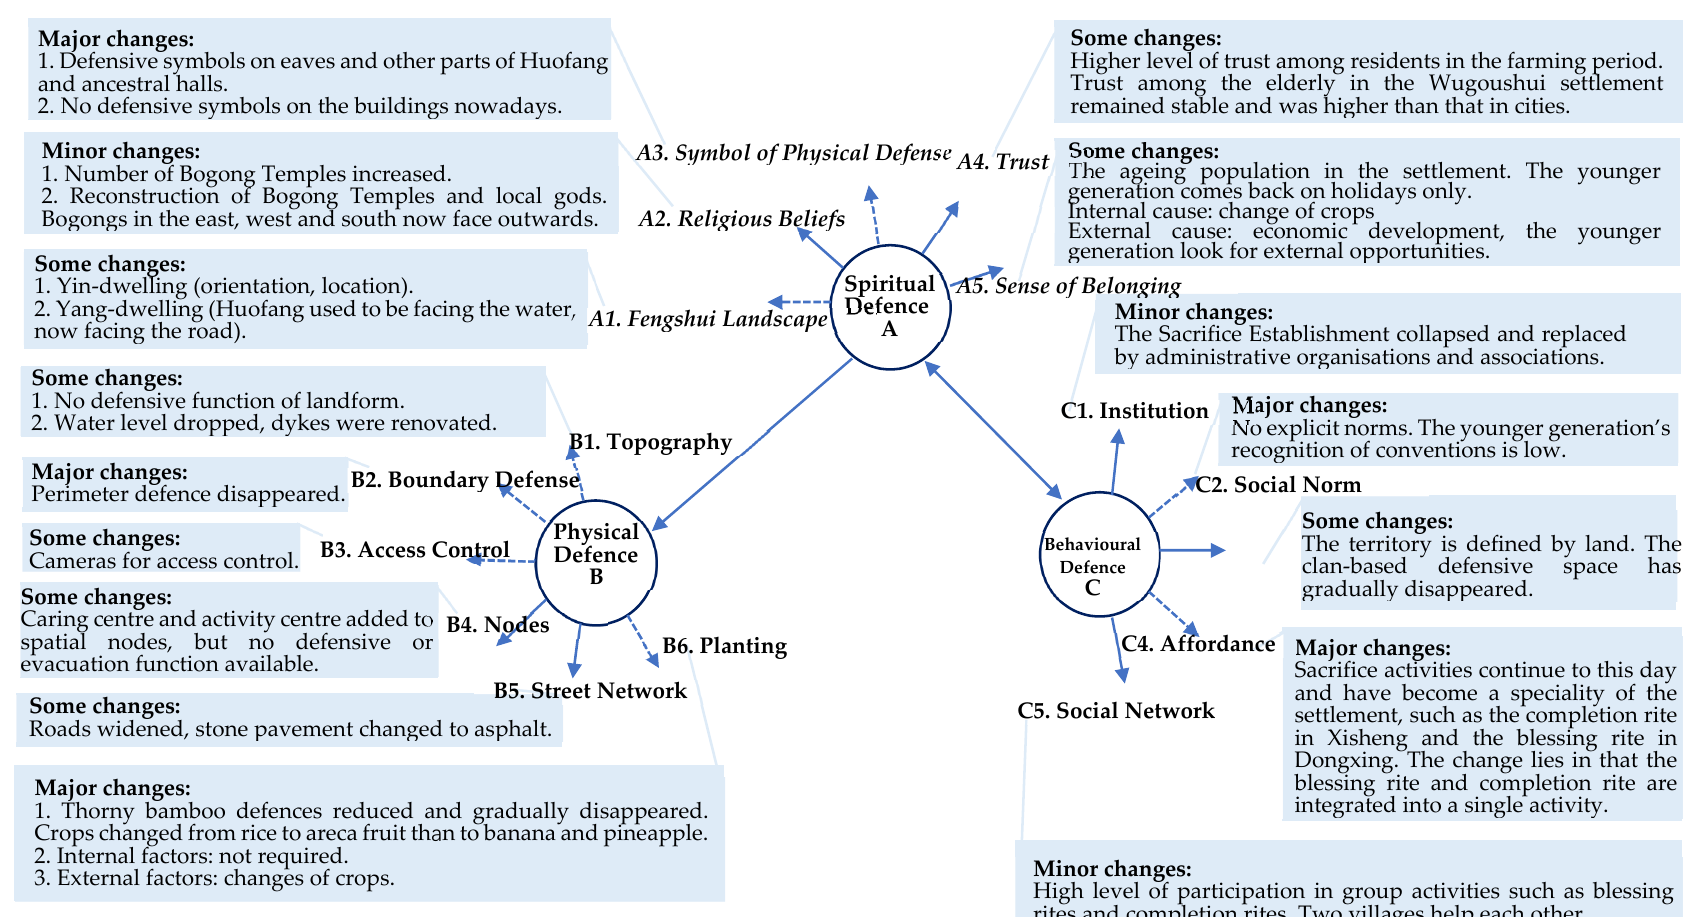
Figure 8. Changes in Wugoushui’s Defensive Criteria (Source: plotted in this study).